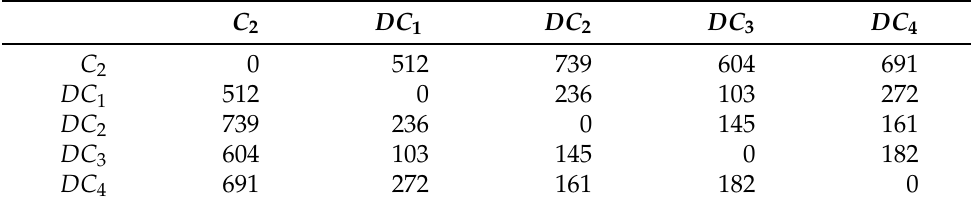
Table 7. Spatial distance between nodes [kilometer], referring to the second supplier.